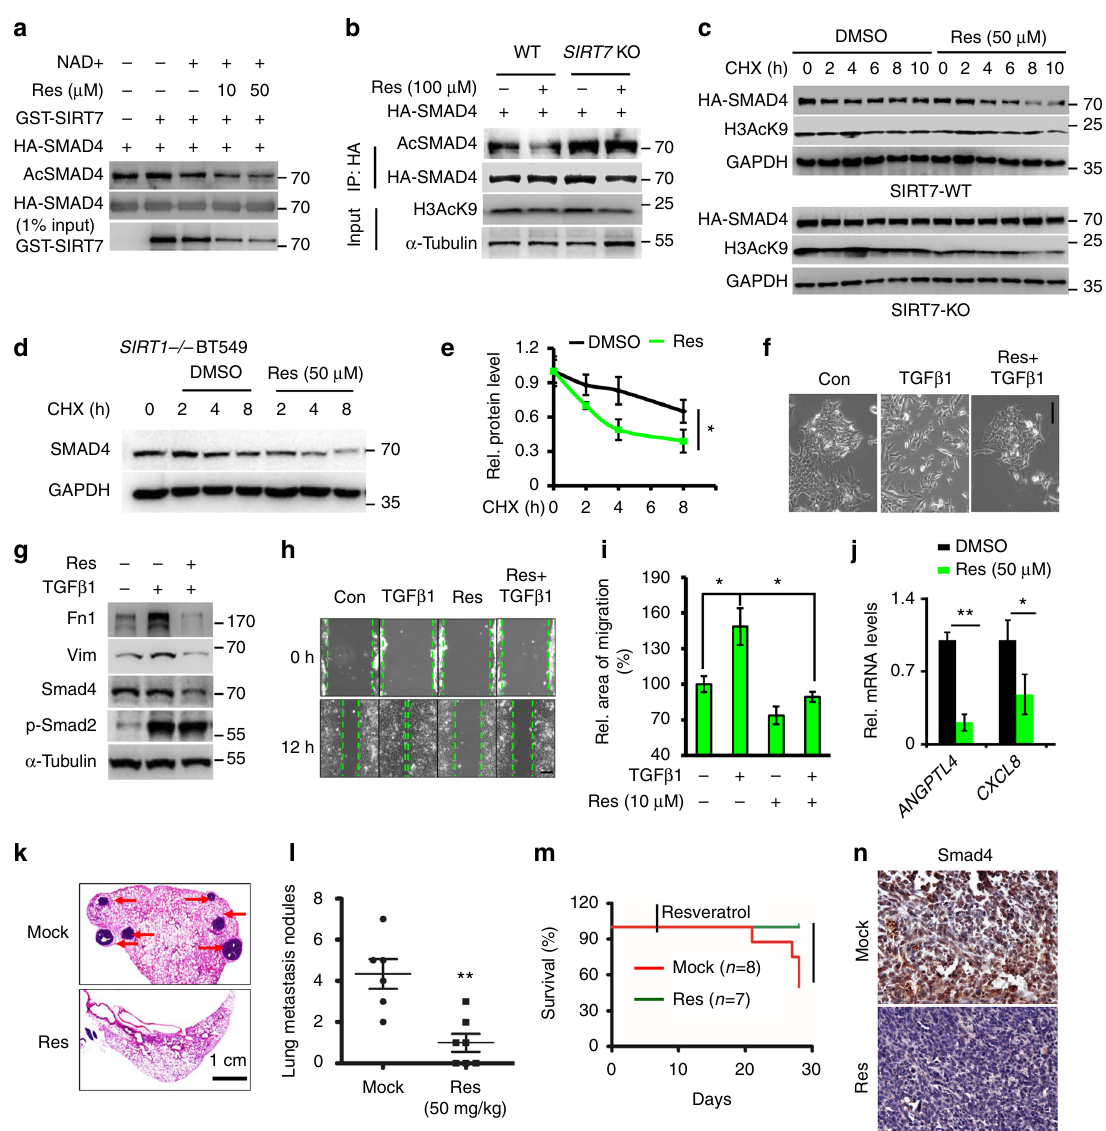
Fig. 8 Resveratrol activates SIRT7 and inhibits metastasis. a Immunoblots showing SMAD4 acetylation level in an in vitro SIRT7 deacetylation assay: 2 mM NAD + , 1 µ g GST-SIRT7, bead-bound HA-SMAD4, and Resveratrol (Res) were included as indicated. b Immunoblots showing SMAD4 acetylation level in wild-type or SIRT7 KO HEK293T cells treated with resveratrol. Note the SIRT7-dependent effect of SMAD4 deacetylation and SIRT7-independent effect of H3K9 deacetylation. c Resveratrol treatment accelerated the protein degradation of HA-SMAD4, and that was abolished in SIRT7 KO cells. d Representative immunoblots showing accelerated SMAD4 degradation upon resveratrol treatment in SIRT1 KO BT549 cells. e Quanti fi cation of d by Image J; f Phase contrast images of 4T1 cells showing epithelial or mesenchymal features. Noted that Resveratrol inhibited EMT. Scale bar , 100 µ m. g Immunoblots showing decreased Smad4, Fn1, and Vim upon resveratrol treatment. Noted that p-Smad2 levels were not affected. h Wound healing assay for 4T1 cells treated with TGF- β 1 (5 ng/ml) and/or resveratrol. Scale bar , 200 µ m. i Quanti fi cation of migration ability in h , represented as relative migration area calculated by Image J. j Quantitative RT-PCR analysis of ANGPTL4 and CXCL8 mRNA levels in breast cancer cells treated with resveratrol or vehicle. k Representative images of H&E staining lung metastatic nodules in Balb/c mice injected with 4T1 cells and treated with resveratrol on day 7 (50 mg/kg). Scale bar , 1 cm. l Scatter blot showing lung metastatic nodules. m Kaplan – Meier survival of mice in k . * P < 0.05, calculated by log rank test. n Representative IHC staining of Smad4 in lung metastases from 4T1 mice k . Scale bar , 100 μ m. * P < 0.05, ** P < 0.01. P- values are calculated by one-way analysis of